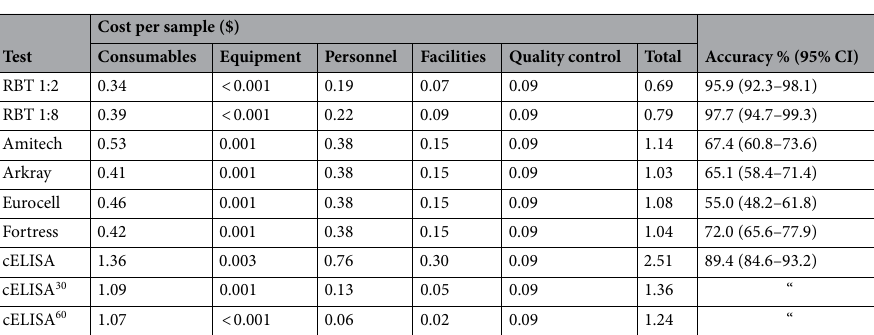
Table 3. Cost per sample in United States dollars and diagnostic accuracy estimates for each index test evaluated (with 95% confidence intervals; 95% CI). The first seven rows indicate costs assuming testing of five samples per batch, six batches per week, and 52 weeks per year. Rows for cELISA 30 and cELISA 60 represent costs assuming testing of 30 samples per batch, one batch per week and 60 samples per batch, one batch per two weeks, for cELISA, respectively. CI: confidence interval. RBT: the Rose Bengal test. cELISA: competitive enzyme-linked immunosorbent